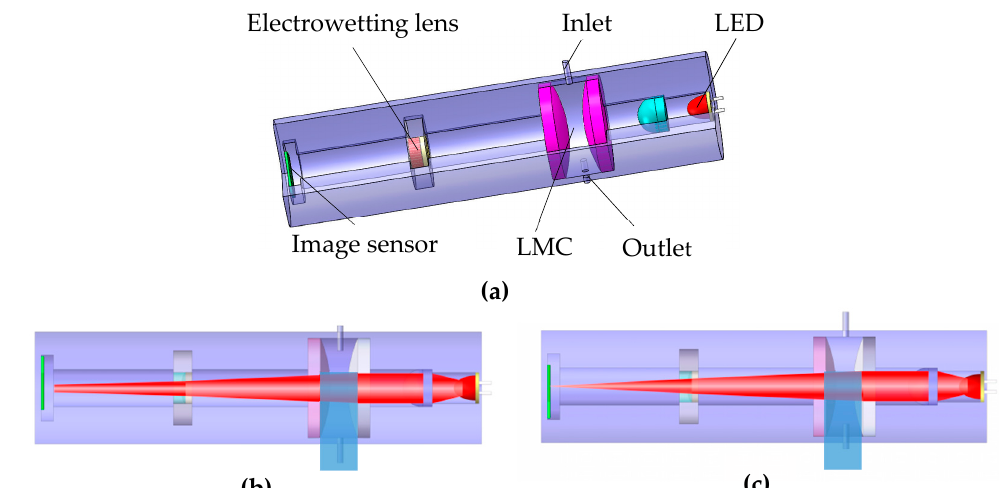
Figure 1. Structure and mechanism of the proposed system. ( a ) Cross-section of the system. ( b ) State of voltage off. ( c ) State of voltage on. (Where LMC is the liquid measurement chamber and LED refers to the light emitting diode).